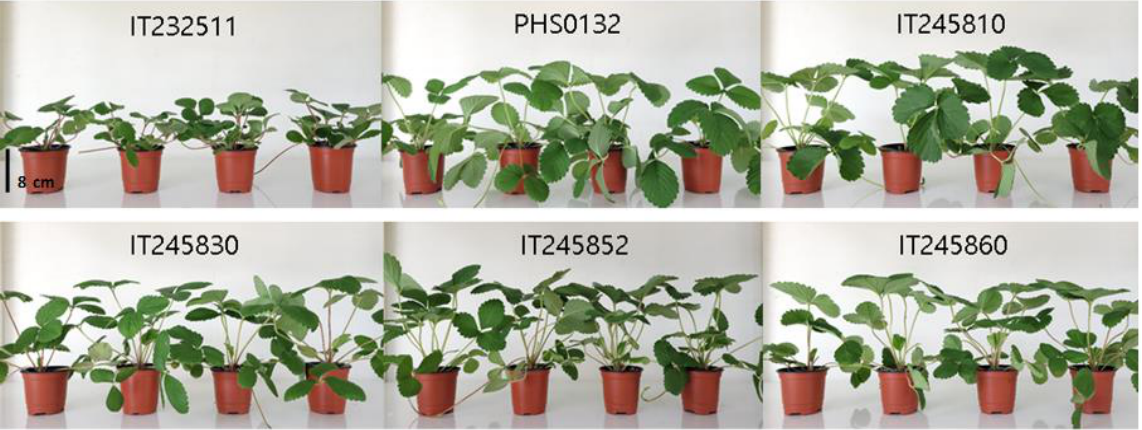
Figure 2. Vegetative growth comparisons of four treatments for six strawberry accessions (plant orders from the left in each accession; GH, greenhouse maintained; TC, tissue culture; +LN, liquid nitrogen exposure; −LN , non-liquid nitrogen exposure). Photos were taken three months after the planting in the pot.